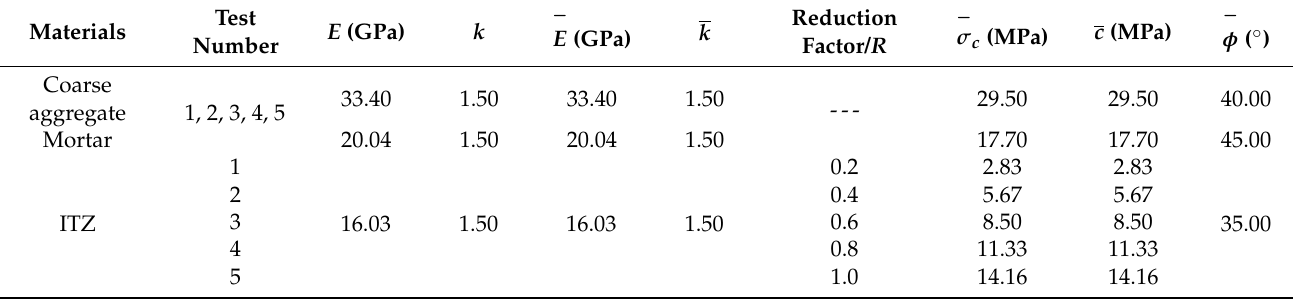
Table 2. Parameters scheme.